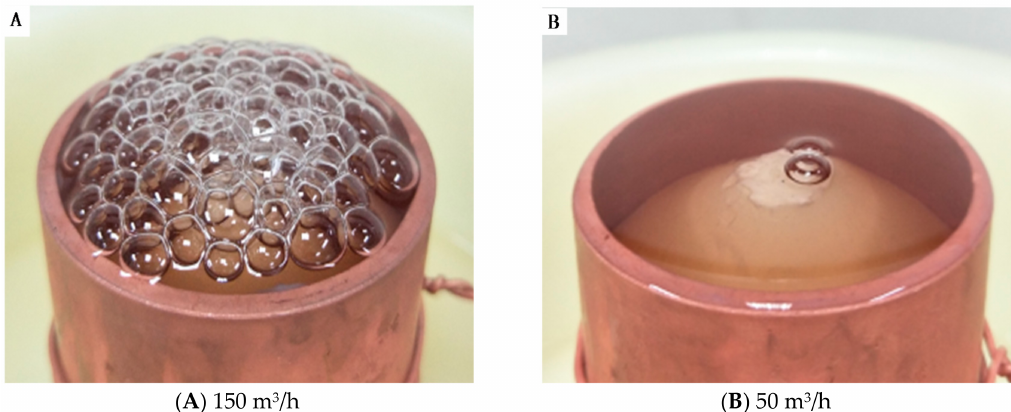
Figure 2. Photograph of the MBE with different gas flow volume of ( A ) 150 m 3 /h and ( B ) 50 m 3 /h,